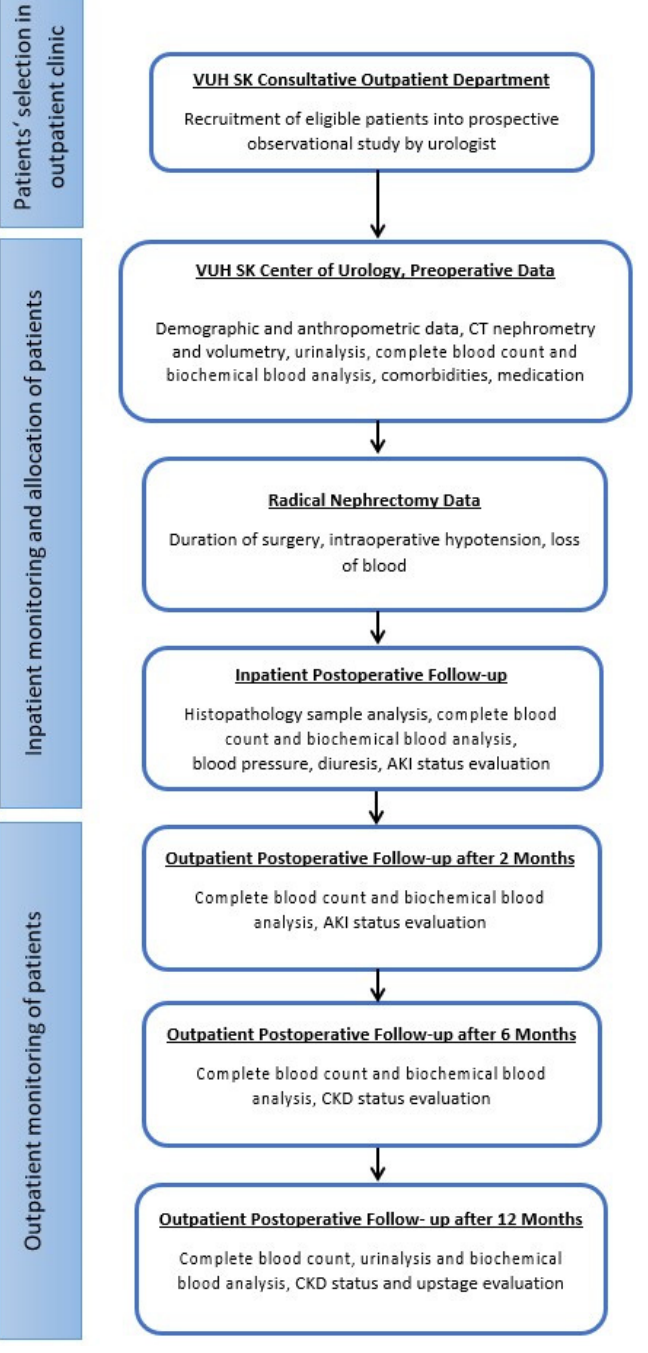
Figure 1. The study design and methodology. Abbreviations: VUH SK—Vilnius University Hospital Santaros Klinikos; CT—computed tomography; AKI—acute kidney injury; CKD—chronic kidney disease.